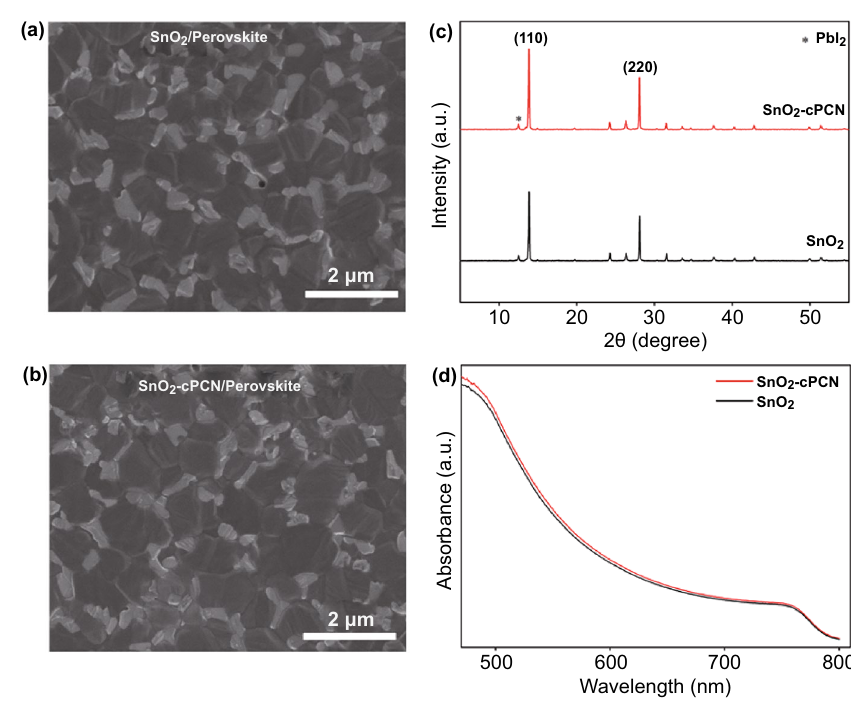
Fig. 3 Top view SEM images of perovskite films coated on a SnO 2 and b SnO 2 -cPCN substrates. c XRD patterns and d UV–Vis spectra of the perovskite films on